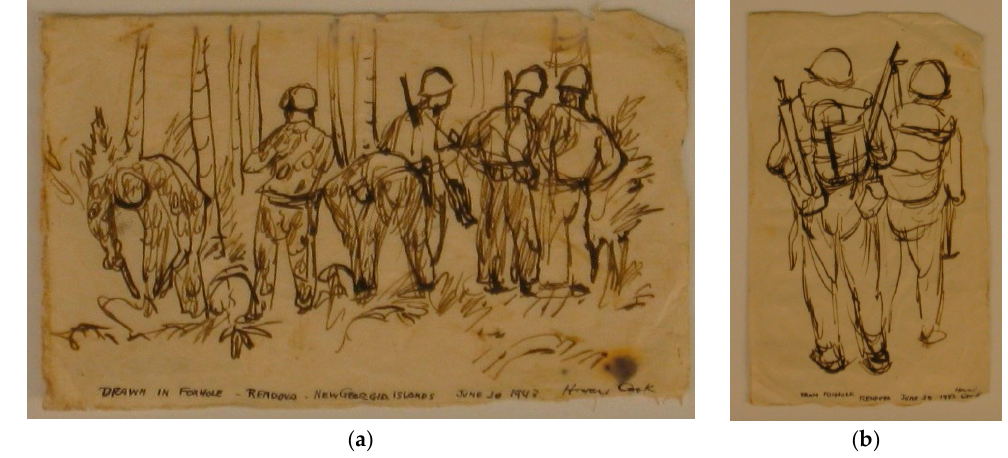
Figure 5. The two drawings Cook completed in the foxhole: ( a ) Howard Cook, Drawn in a Foxhole , Rendova New Georgia , 1943, ink on paper. Permanent Collection of the Roswell Museum and Art Center, Gift of the Howard Cook Estate, 1981.018.0391. Used with permission. ( b ) Howard Cook, From Foxhole , Rendova , 1943, ink on paper. Permanent Collection of the Roswell Museum and Art Center, Gift of the Howard Cook Estate, 1981.018.0392. Used with permission.